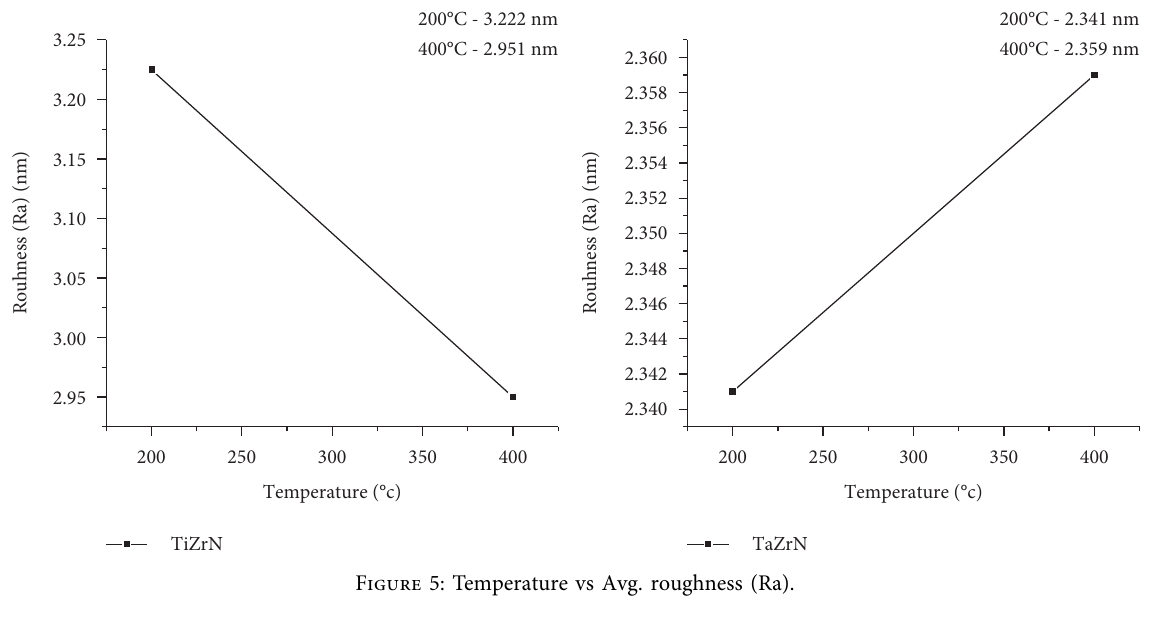
Figure 5: Temperature vs Avg. roughness (Ra).